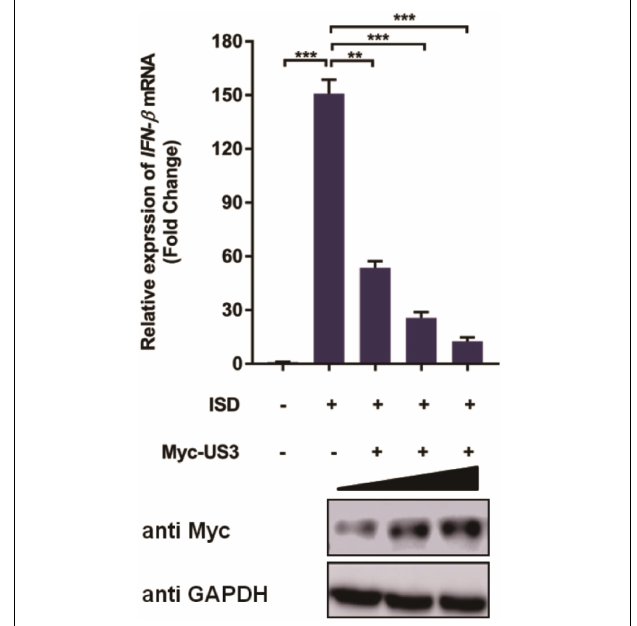
FIGURE 1 | pCMV-Myc-US3 plasmid (0.2 µ g, 0.5 µ g, and 1.0 µ g) was transfected into PK15 cells used Lipofectamine 3000. ISD (2 µ g/mL) was transfected into above cells for 12 h before cells collection. US3 protein expression was detected by western blotting. An anti-Myc antibody was used and GAPDH served as the loading control. Then cellular RNA were extracted and cDNA was transcripted for IFN- β mRNA detection. Data were listed as mean ± SD from three independent experiments. Comparison between two groups was evaluated by unpaired Student’s t test. ** p < 0.01, *** p <